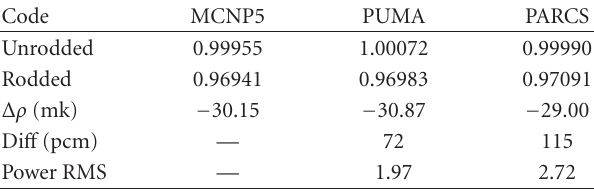
Table 10: CNA-II idealized core—full rod insertions.